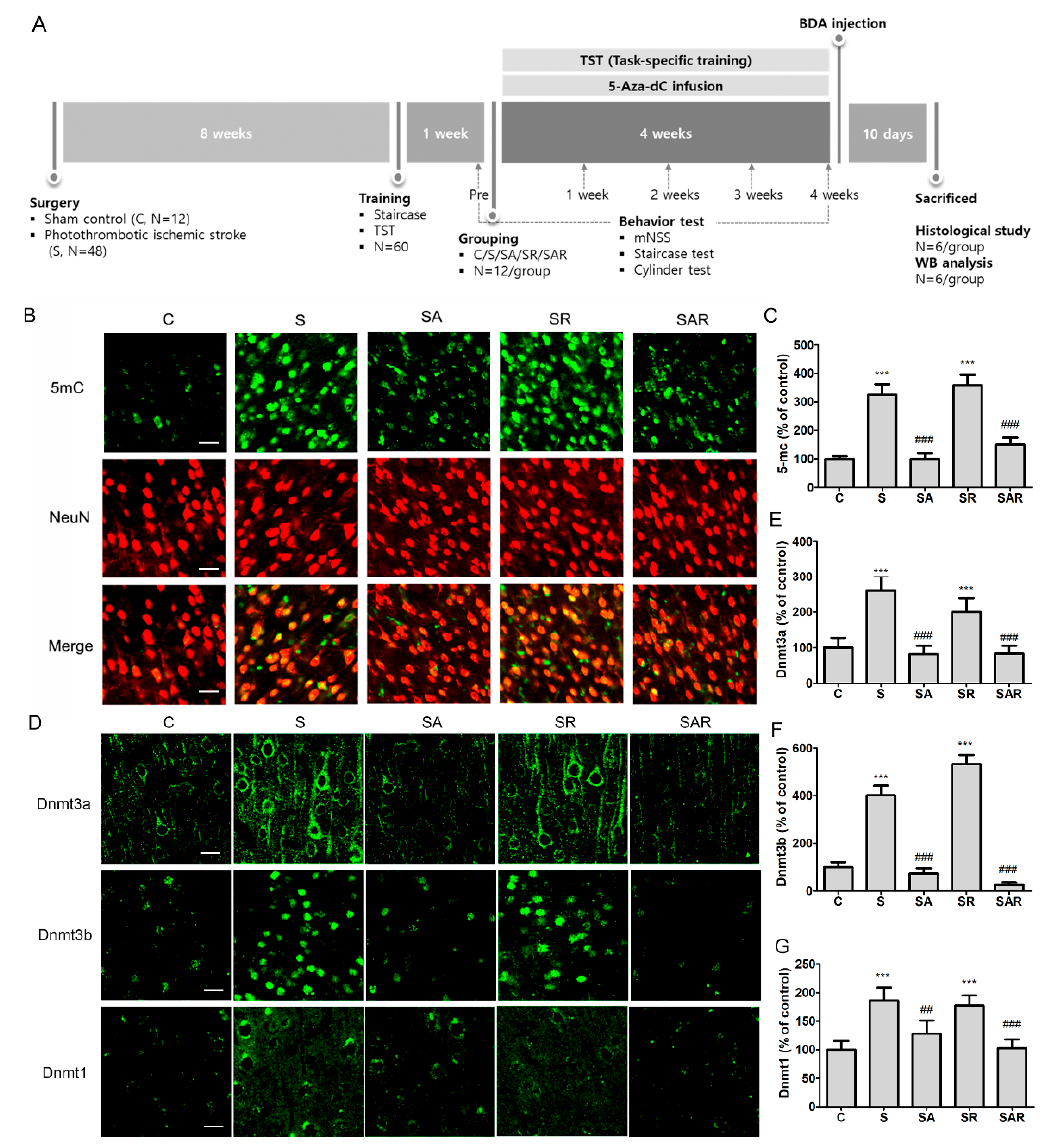
Figure 3. The timeline of the experiment and expressions of 5 mc, Dnmt3a, Dnmt3b, and Dnmt1 in the contralesional cortex after a stroke. ( A ) In a study on the effect of TST and DNMT inhibition on the functional recovery of chronic stroke, sham control (C) and stroke rats (S) with or without TST (SR) and with or without 5-Aza-dC (SA or SAR) were used for behavior test, neural plasticity, protein expression studies, and immunohistochemical analysis; ( B ) representative photomicrograph of 5-mc (green), NeuN (red) and co-localized merged cells (yellow) and ( D ) Dnmt3a, Dnmt3b, or Dnmt1 immunostaining in the contralesional cortex after stroke; ( C , E – G ) Counts of 5-mc, Dnmt3a, Dnmt3b, or Dnmt1 positive cells. Results are presented as the mean ± SEM, n = 6/group. *** p < 0.001 vs. C, ## p < 0.01; ### p < 0.001 vs. S, Scale bars = 20 μ m. 2.3. Infarct Volume Was Not Altered by TST with or without 5-Aza-dc in the Chronic Phase after Severe Stroke